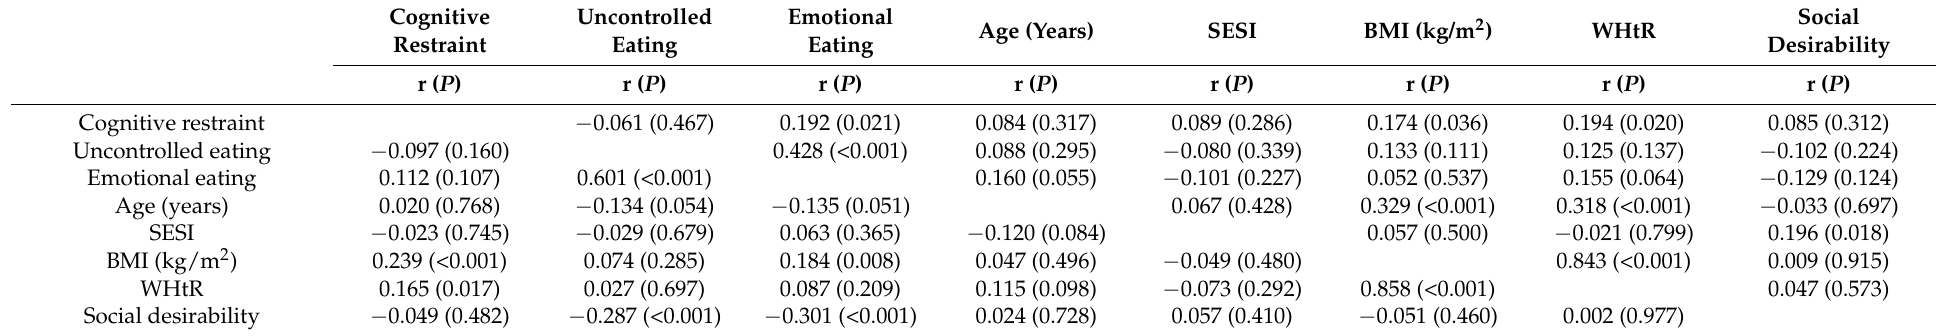
Table 2. Correlations between eating behaviour dimensions, age, SESI, BMI, WHtR, and social desirability among males ( n = 144) and females ( n =